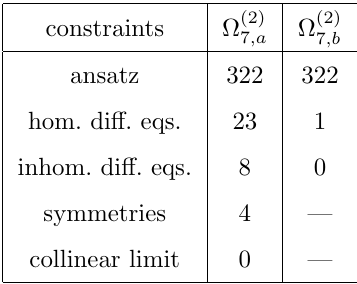
Table 1 . Number of unconstraint coe(cid:14)cients in the heptagon Steinmann ansatz after applying various constraints for both two-loop heptagon